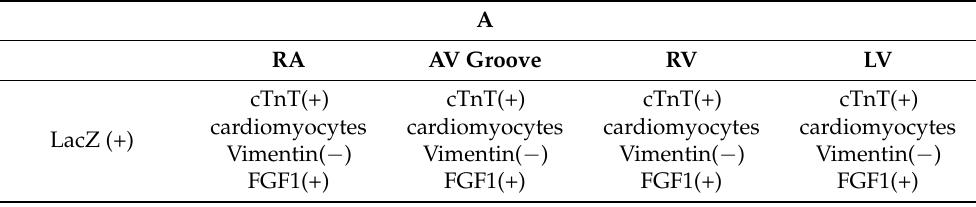
Table 2. Comparison of LacZ-positive cells and RFP-positive cells in different regions of heart tissues in F1A-CreER T2 /ROSA26 and F1A-CreER T2 mice, respectively